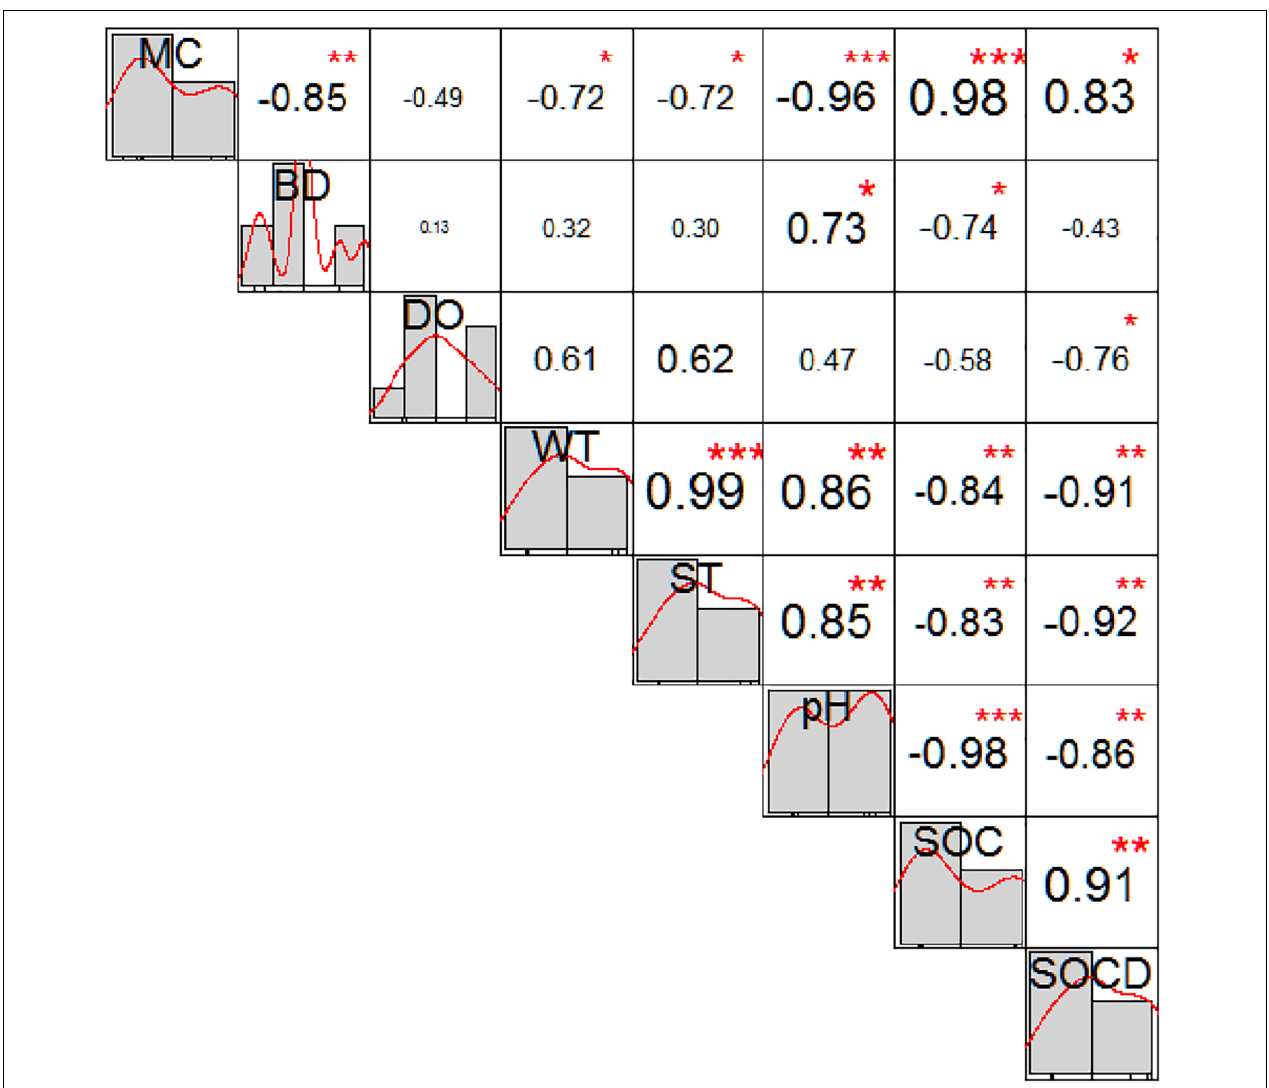
FIGURE 3 | Spearman correlation matrix for SOC and soil physicochemical properties in Xinxue River (XR) and Xinxue River Constructed Wetland (XC). SOC, Soil organic carbon content; SOCD, soil organic carbon density; MC, moisture content; BD, bulk density; DO, dissolved oxygen; WT, water temperature; ST, soil temperature. Diagonal shows the variable distribution diagram; the top right of the diagonal shows the Spearman correlation coefficient and the level of significance, the size of the number reflects the value of the correlation (* p < 0.05; ** p < 0.01; *** p <